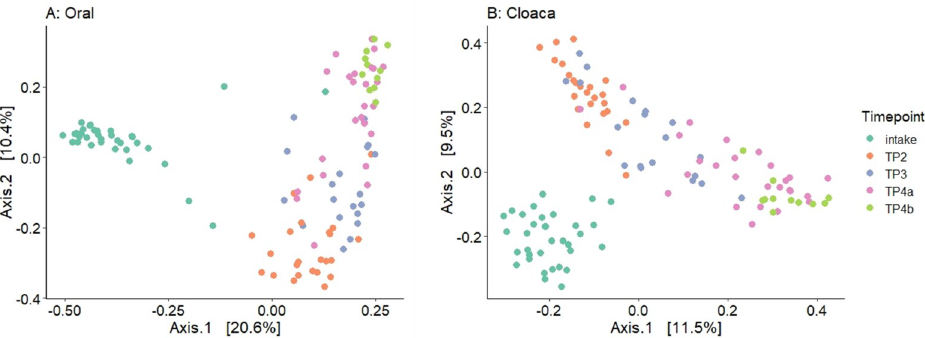
Fig 5. Microbial communities across all timepoints. Principal coordinate analysis (PCoA) plots of oral samples (A) and cloacal samples (B) based on Bray-Curtis distance. Color indicates timepoint in rehabilitation from intake to convalescence (TP4a)/pre-release